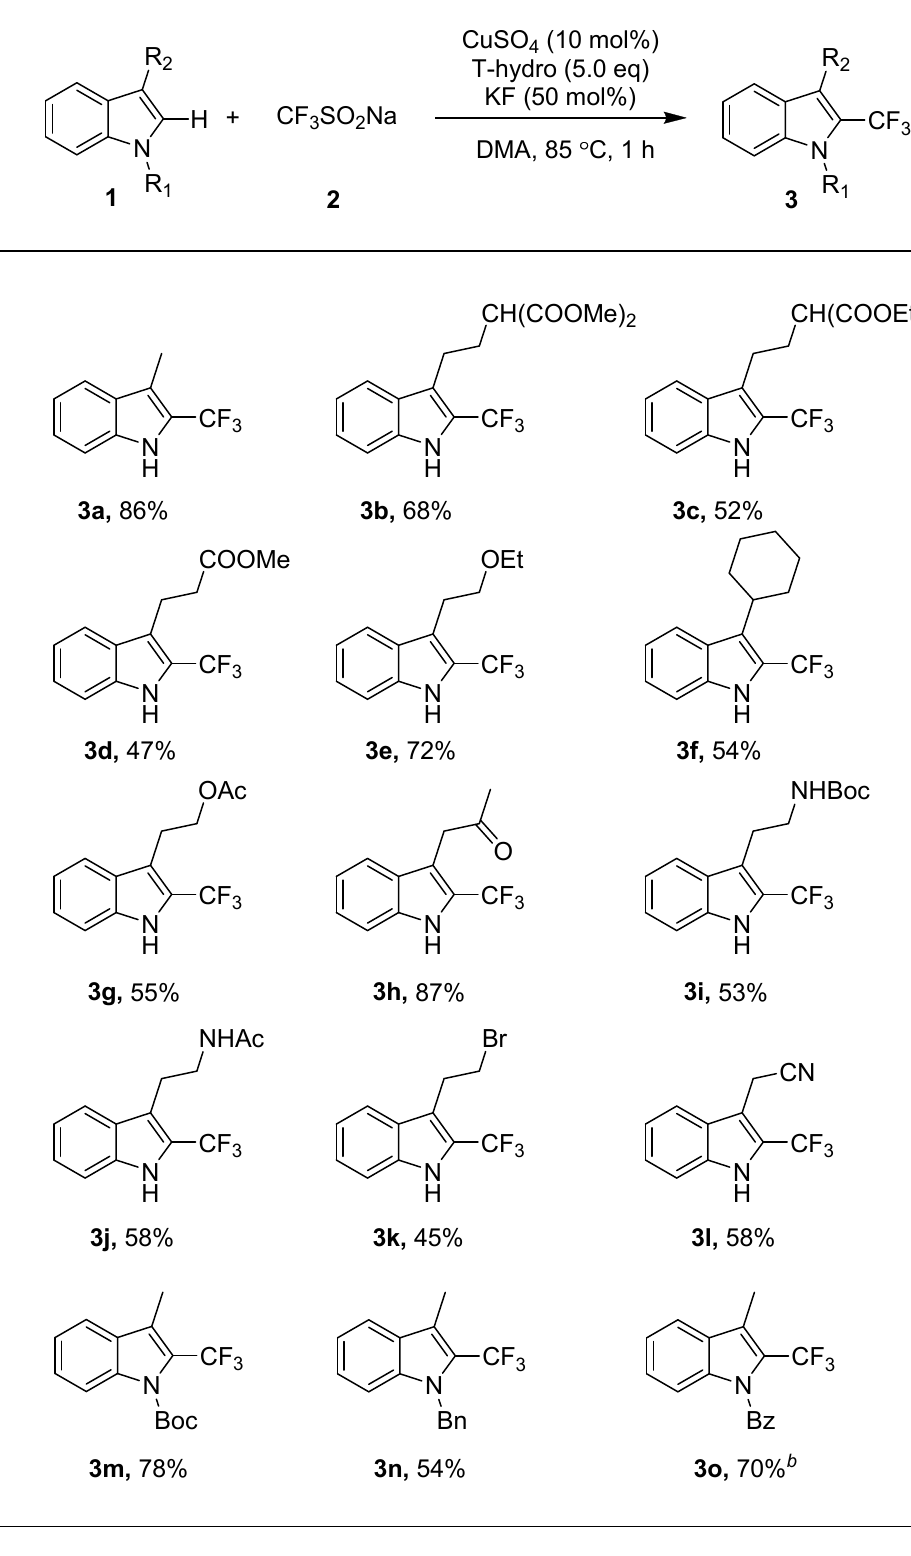
Figure 1. Reaction scope of the 3-indoles and the N -indoles a . a Conditions: 1 (0.5 mmol), 2 (1.5 mmol), CuSO 4 (10 mol %), t BuOOH (2.5 mmol), KF (50 mol%), DMA (3.0 mL), 85 °C, 1 h, under Ar. Isolated yield. b reaction time: 12 h.